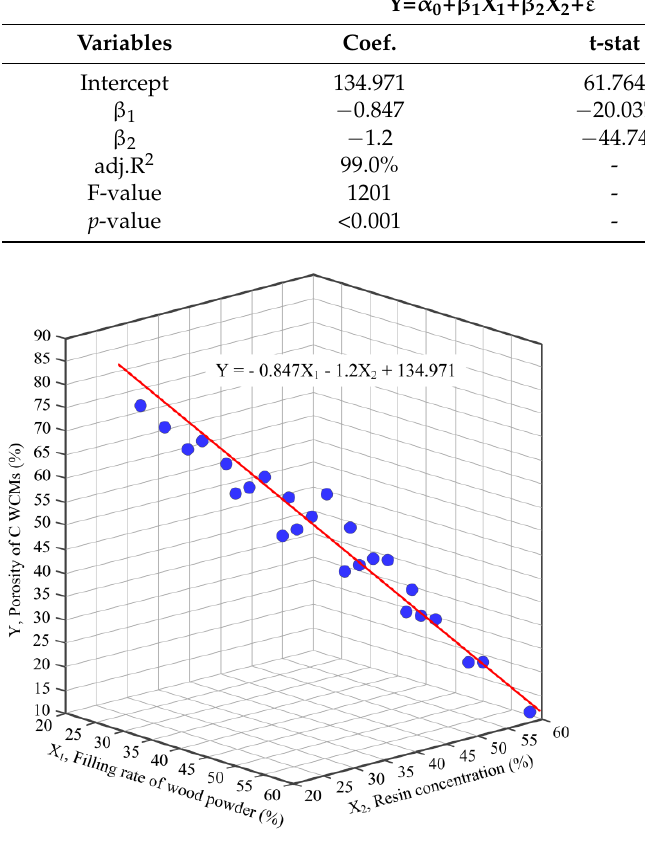
Figure 13. The association among the porosity of C WCMs, filling rate of wood powder and resin concentration, under the condition that the species of wood, the size of wood powder and the sintering process are determined.